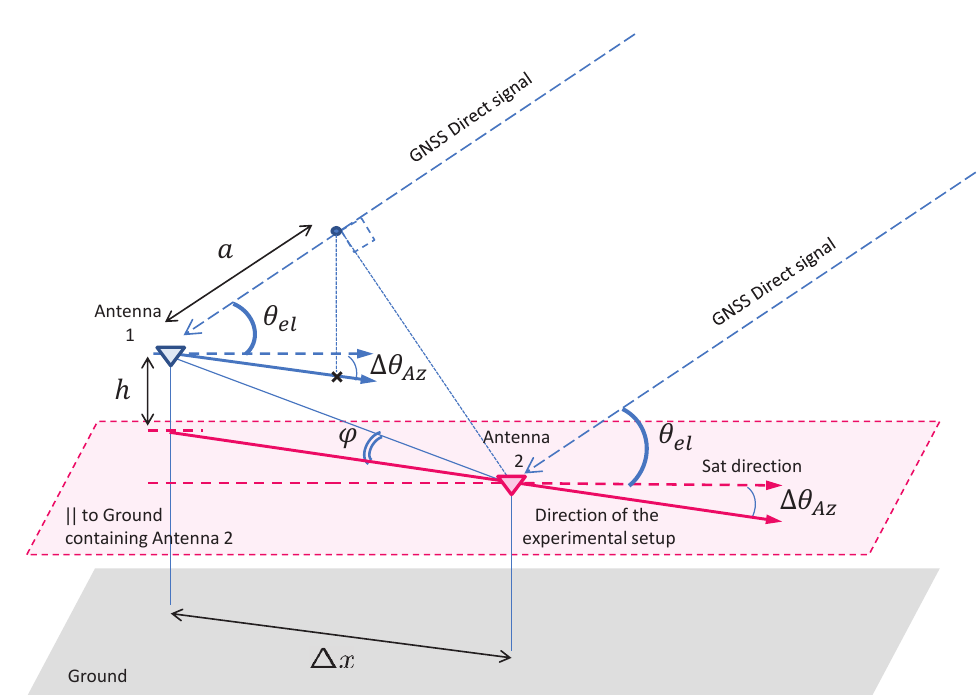
Figure 9. Geometry of the